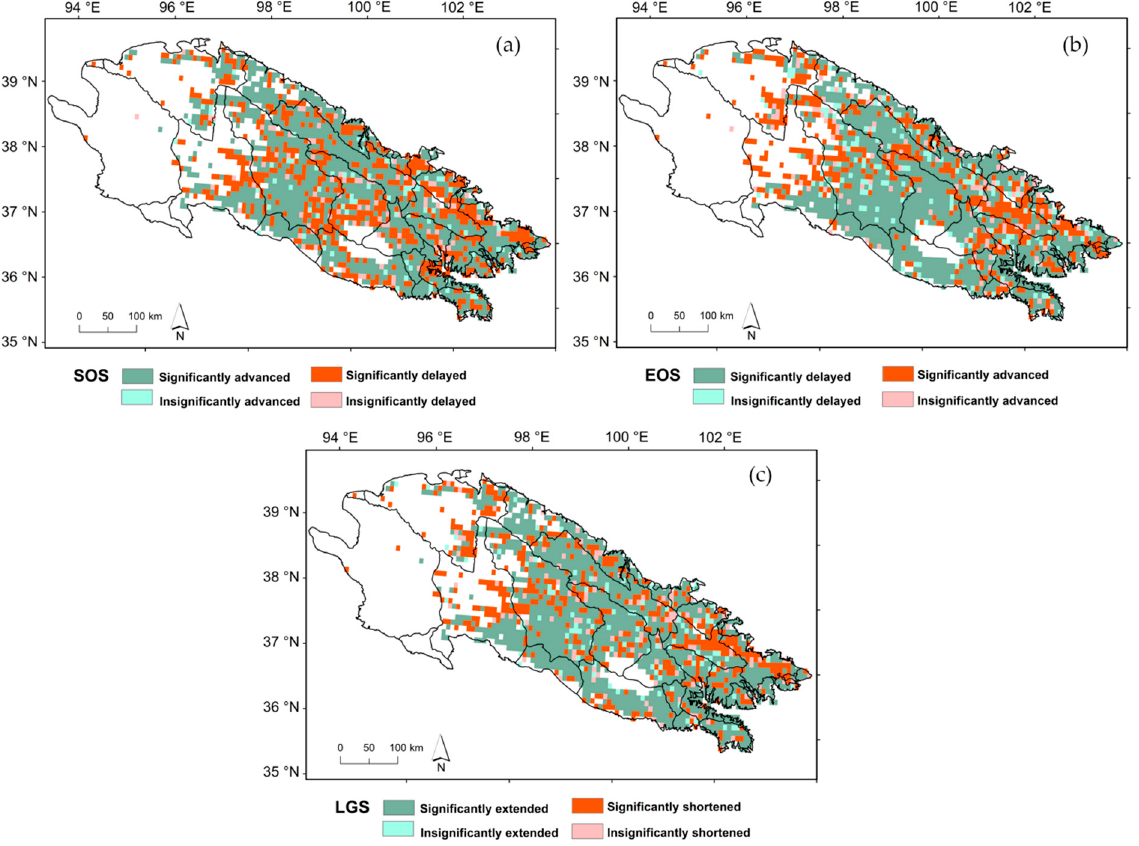
Figure 4. The spatial distribution of the phenological trends for 34 years from 1982 to 2014 in the Qilian Mountains, including the SOS, EOS, and LGS. ( a ) The spatial distribution of the SOS trend; ( b ) the spatial distribution of the EOS trend; ( c ) the spatial distribution of the LGS trend. The significant trend corresponds to a p -value of < 0.05.